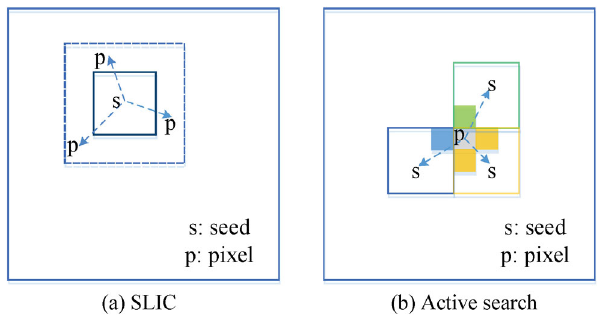
Fig. 1 (a) Search method used in SLIC. Each seed only searches over a limited region to reduce computational cost. (b) Our active search method. Each pixel decides its own label by searching its